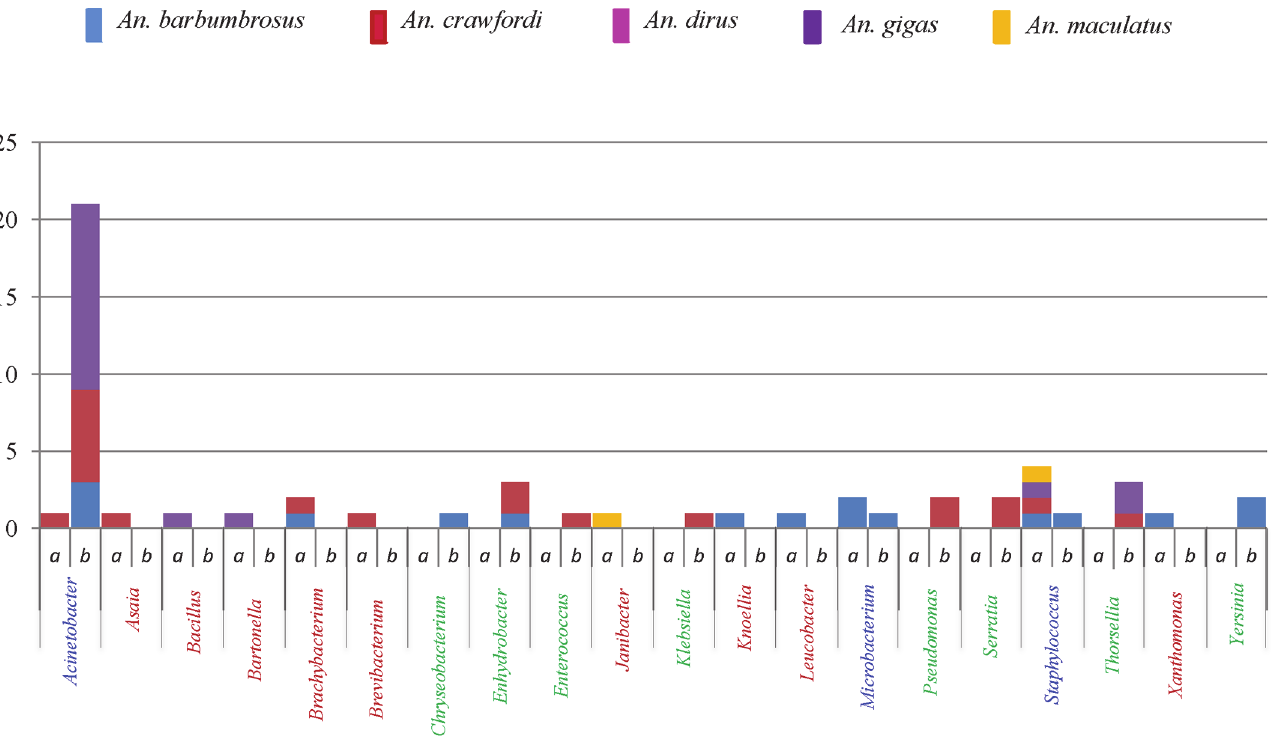
Fig 3. Bacterial genera detected in 52 wild-caught Anopheles mosquitoes using of culture-dependent (a) and culture-independent (b) methods, displayed by the number of positive samples in each Anopheles species. Out of 3 An . dirus analyzed, no specimen showed detectable bacteria. Number of genera detected per method such as 9 by culture-dependent (red characters), 8 by culture-independent (green characters) and 3 genera detected by both methods (blue characters).